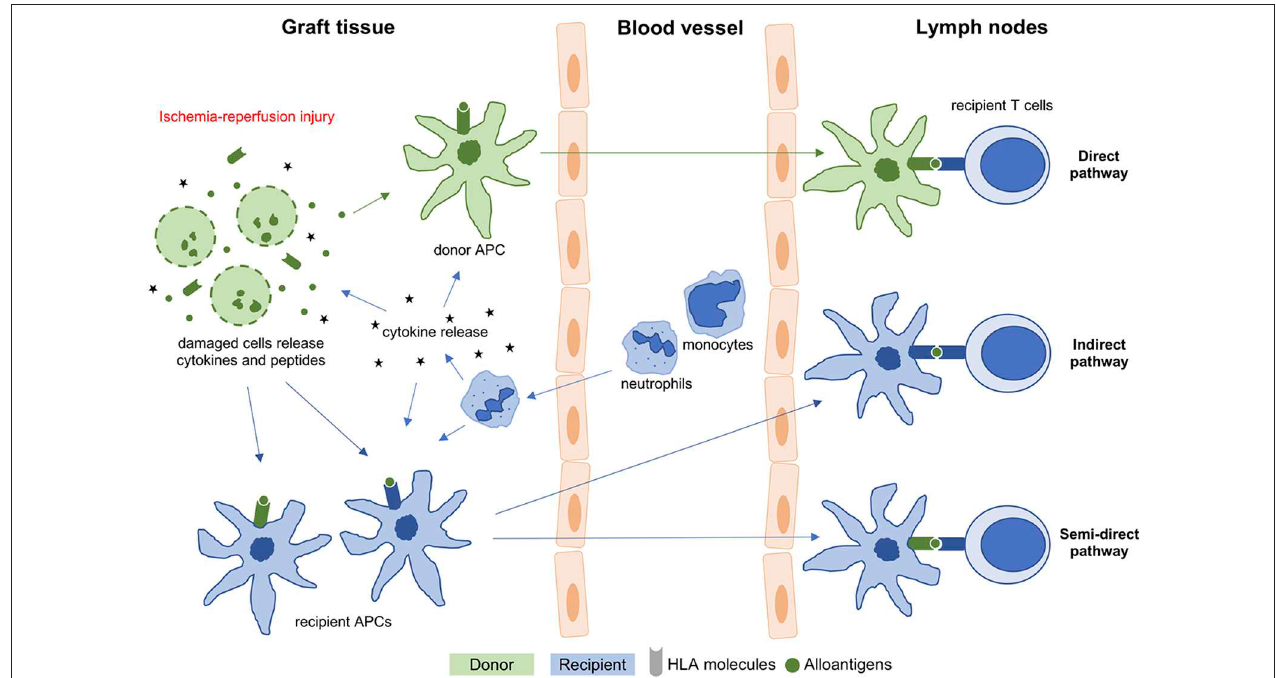
FIGURE 1 | T cell allorecognition pathways in organ transplantation. APC, antigen-presenting cell; HLA, human leukocyte